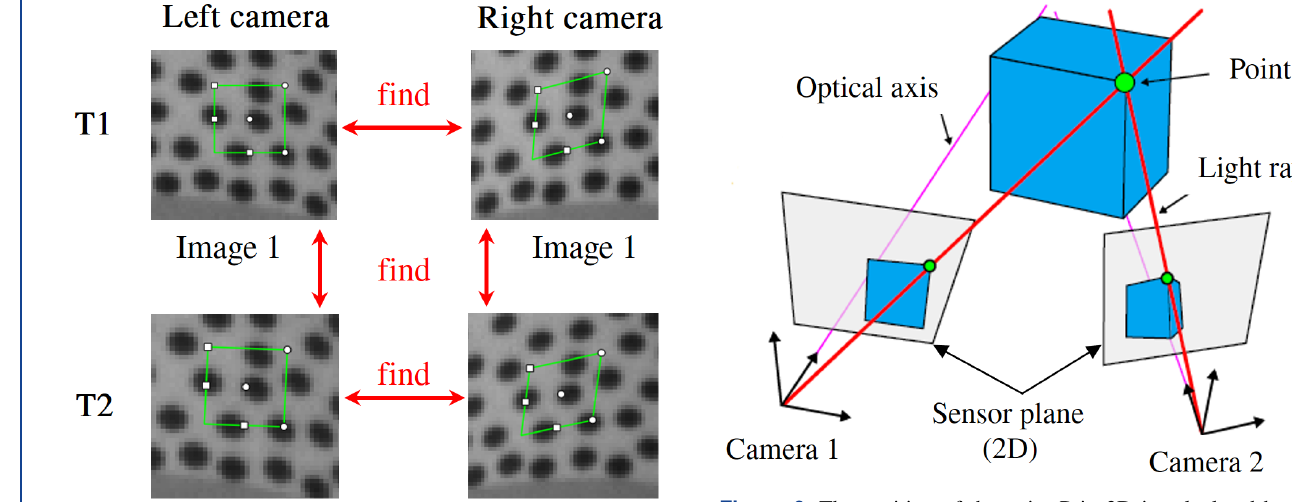
Figure 6. The position of the point P in 3D is calculated by the position of the two cameras relative to the wind turbine and the individual position of the measurement point in the left and right